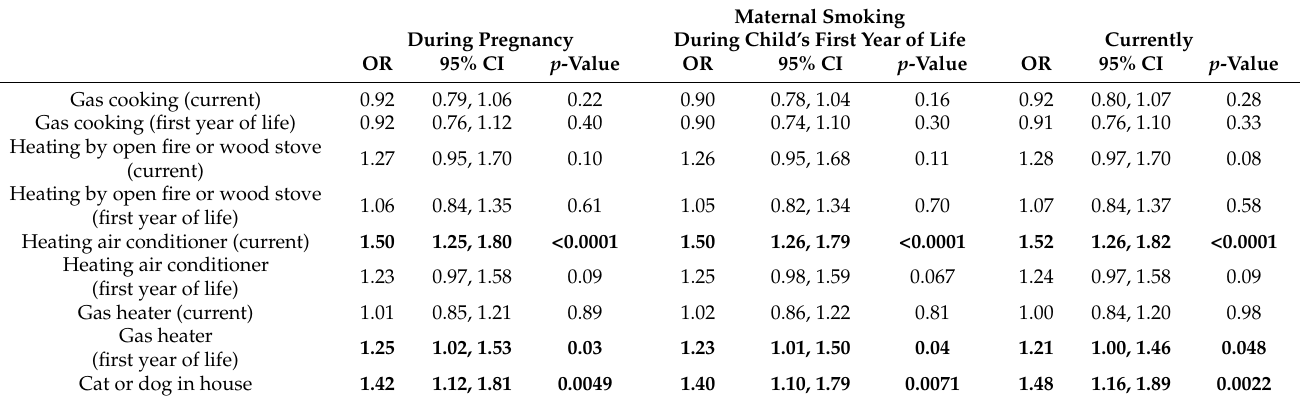
Table 3. Associations between indoor environmental exposures and otitis media with additional adjustment for maternal smoking